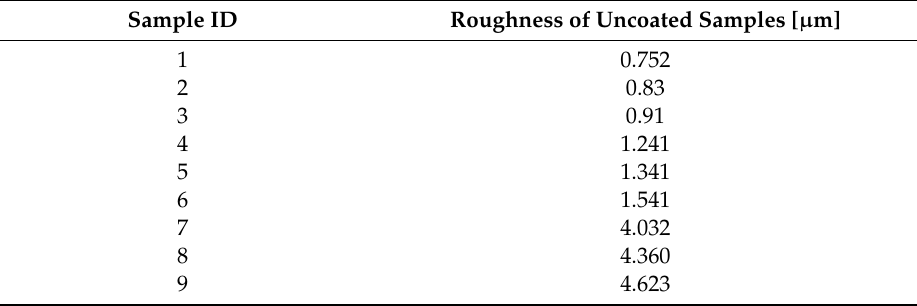
Table 1. ID samples with roughness ranging between 0.7 and 4.6 µm.